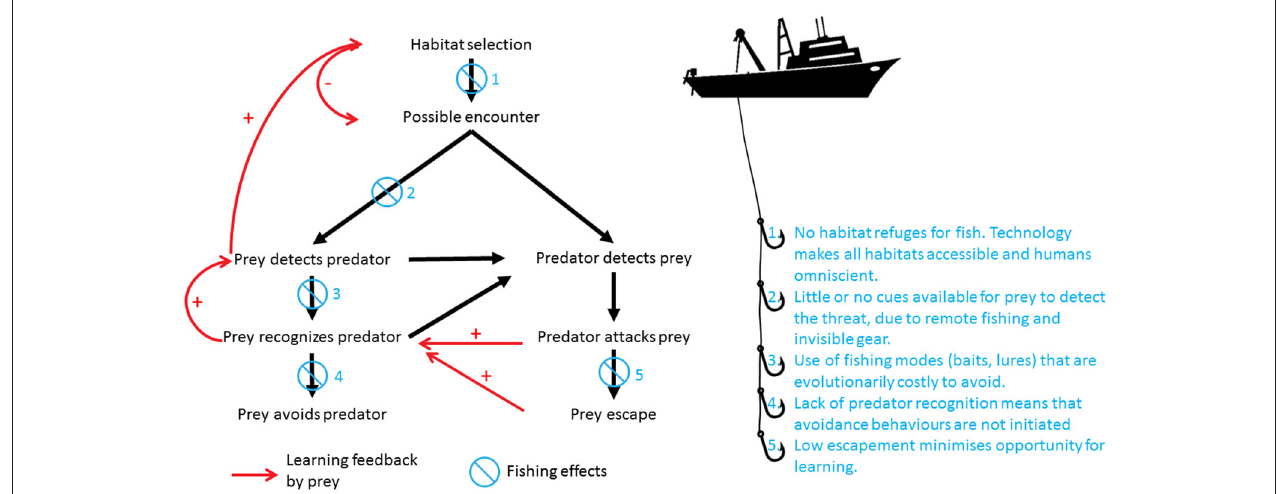
FIGURE 2 | Unlike any other predator in marine systems, humans have the ability to influence the outcome of the entire predation sequence. This Figure summarizes how this occurs. Initially, prey choose habitats that provide a balance between risk of predation and opportunities to access resources (food, mates, shelter). If a predator and a prey are within their limits of sensory detection, the prey can detect the predator first, or alternatively, the predator can detect the prey without it being aware of it. In the case where the threat is detected visually, chemically, or by a combination of both cues, the prey has the opportunity to avoid the threat. In the alternate case where the predator detects the prey and the predator attacks, if the prey escapes it has the opportunity to learn. Moreover, those prey that witnessed the attack but were not directly subjected to it also have the opportunity to recognize the threat posed by the predator through social learning. This learning initiates a feedback loop, in which prey become better equipped to detect, recognize, and avoid predator threats in the future (red arrows in Figure). Ultimately, this might influence their choice of habitat, so that they select those habitats with lower chances of predator encounters. Fishing by humans disrupts the outcomes of every step of this predation sequence. Due to technology (sonar, satellite communications, deep water trawling, long-lining etc.), there is no habitat in which prey can seek refuge from humans as predators (1). Humans fish using remote methods, where there are little or no cues on which prey can focus in order to reduce encounter rates. Additionally, passive fishing gear is effectively invisible to the fish (monofilament lines and nets), and is generally odorless (2). When detection is possible (lures, baits, traps), the cues used for capture are evolutionarily costly to avoid, because they promote low-cost foraging or refuge, two highly selected traits for fitness (3). Even when recognized, the response to the threat may be co-opted by the fisher to increase catches, as is the case for purse-seining, trawling and fish drives (4). All fishing gears are highly efficient and have become more so over time, so that opportunities for escapement and learning are minimized (5). In contrast, evolution has forced non-human predators to focus on only one or two steps of this process using strategies such as crypsis, swimming performance, and enhanced sensory